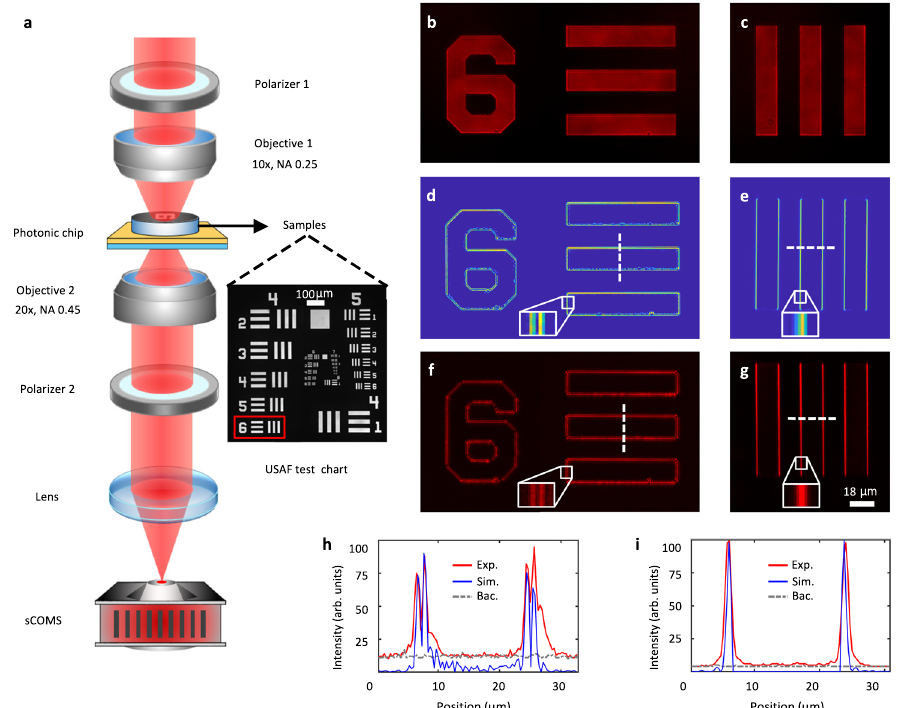
Fig.3|Performanceofthemultiple-orderspatialdifferentiationforamplitude objects. a Schematic of the imaging set-up. The planar chip differentiator was placed directly below a standard 1951 USAF test chart (the sample, inset graph on the left corner).The targetwas illuminatedusinganout-of-focuslinearly-polarized beam at a wavelength of 643nm. b , c Imaging results for the target without the polarizer 2 (analyzer) being placed before the detector. d , e Calculated second- order and fi rst-order derivatives of the images shown in ( b ) and ( c ), respectively. f , g Imaging results for the target when the polarizer 2 was placed before the